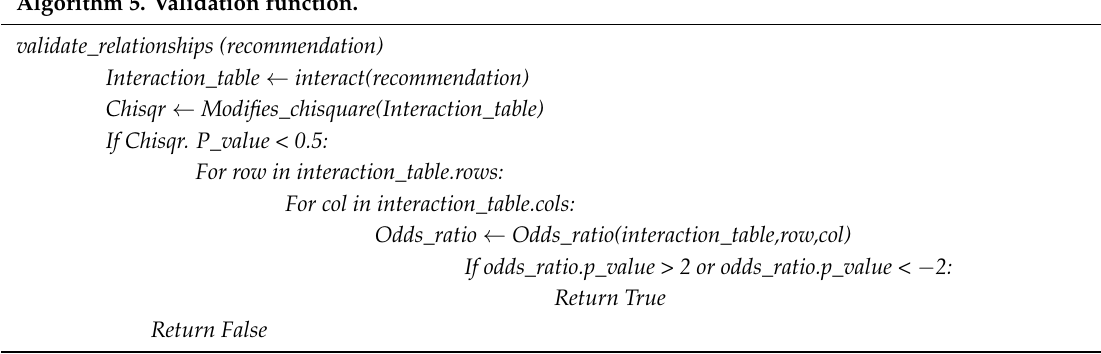
Algorithm 5. Validation